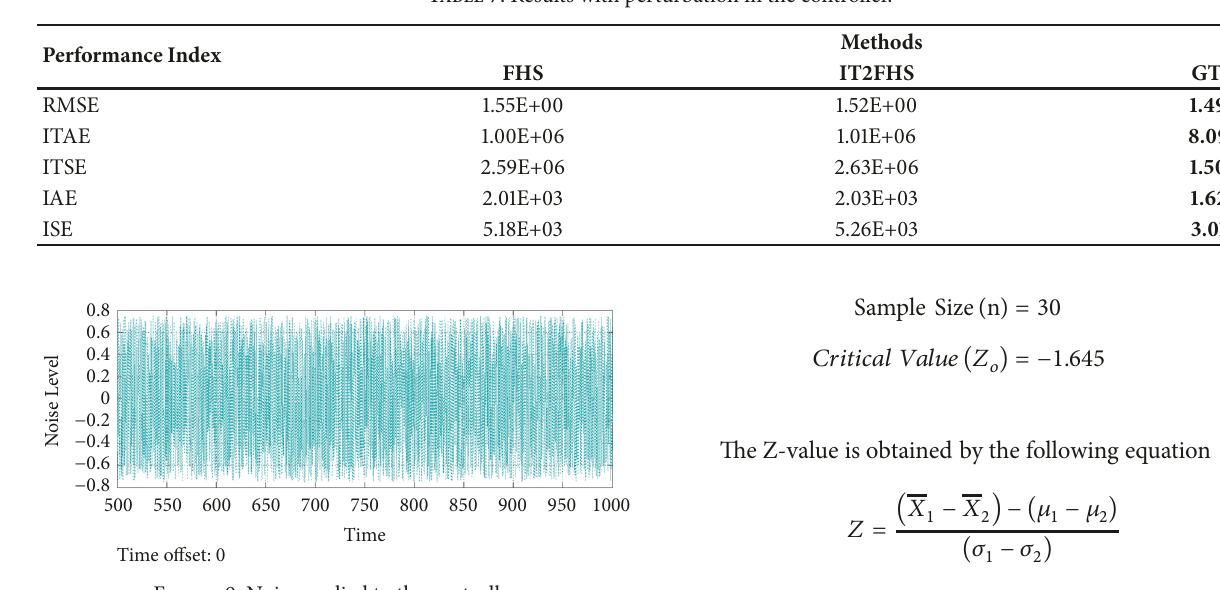
Figure 8: Plant of the ball and beam system. Table 7: Results with perturbation in the controller.